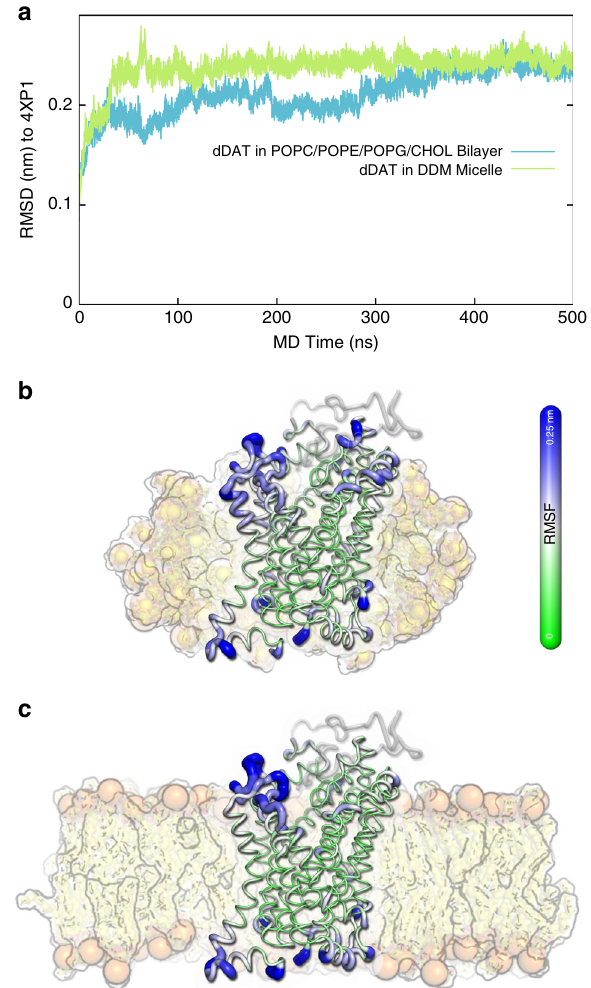
Fig. 1 MD simulations of dDAT embedded in a detergent micelle and a lipid bilayer. a Trajectories of the root-mean-square deviation (RMSD) of the dDAT model to the dDAT crystal structure (PDB ID: 4XP1) when embedded in a DDM micelle (green) and in a POPC/POPE/POPG/CHOL bilayer (blue). b , c Structural fl uctuations of dDAT in a DDM micelle ( b ) and a POPC/POPE/POPG/CHOL bilayer ( c ) are illustrated by projecting the corresponding root-mean-square fl uctuation (RMSF) pro fi les onto the last frame of the MD trajectory of dDAT in the mixed bilayer. The thickness of the tube represents the amplitude of the fl uctuations. To provide a better visualization, the thickness is scaled by the RMSF values in the region from 0 to 0.25 nm (the residues with RMSF> 0.25 nm are considered as the same as RMSF = 0.25 nm). The DDM micelle and the lipid bilayer used